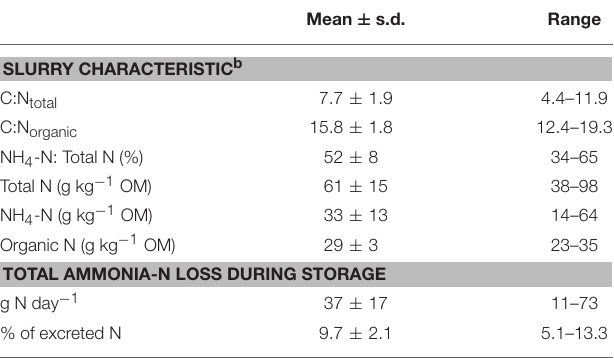
TABLE 7 | Mean values and ranges of simulated slurry composition after 4 months of storage and simulated ammonia losses for 40 nutritional strategies a for dairy